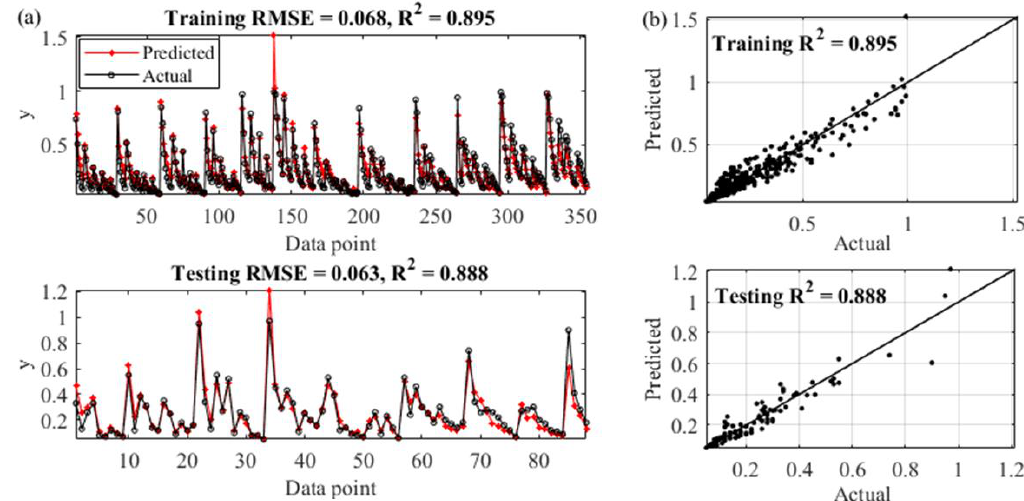
Figure 8. The actual and SGGP results: ( a ) results at all the data points; and ( b ) scatter plots of the actual and predicted results.